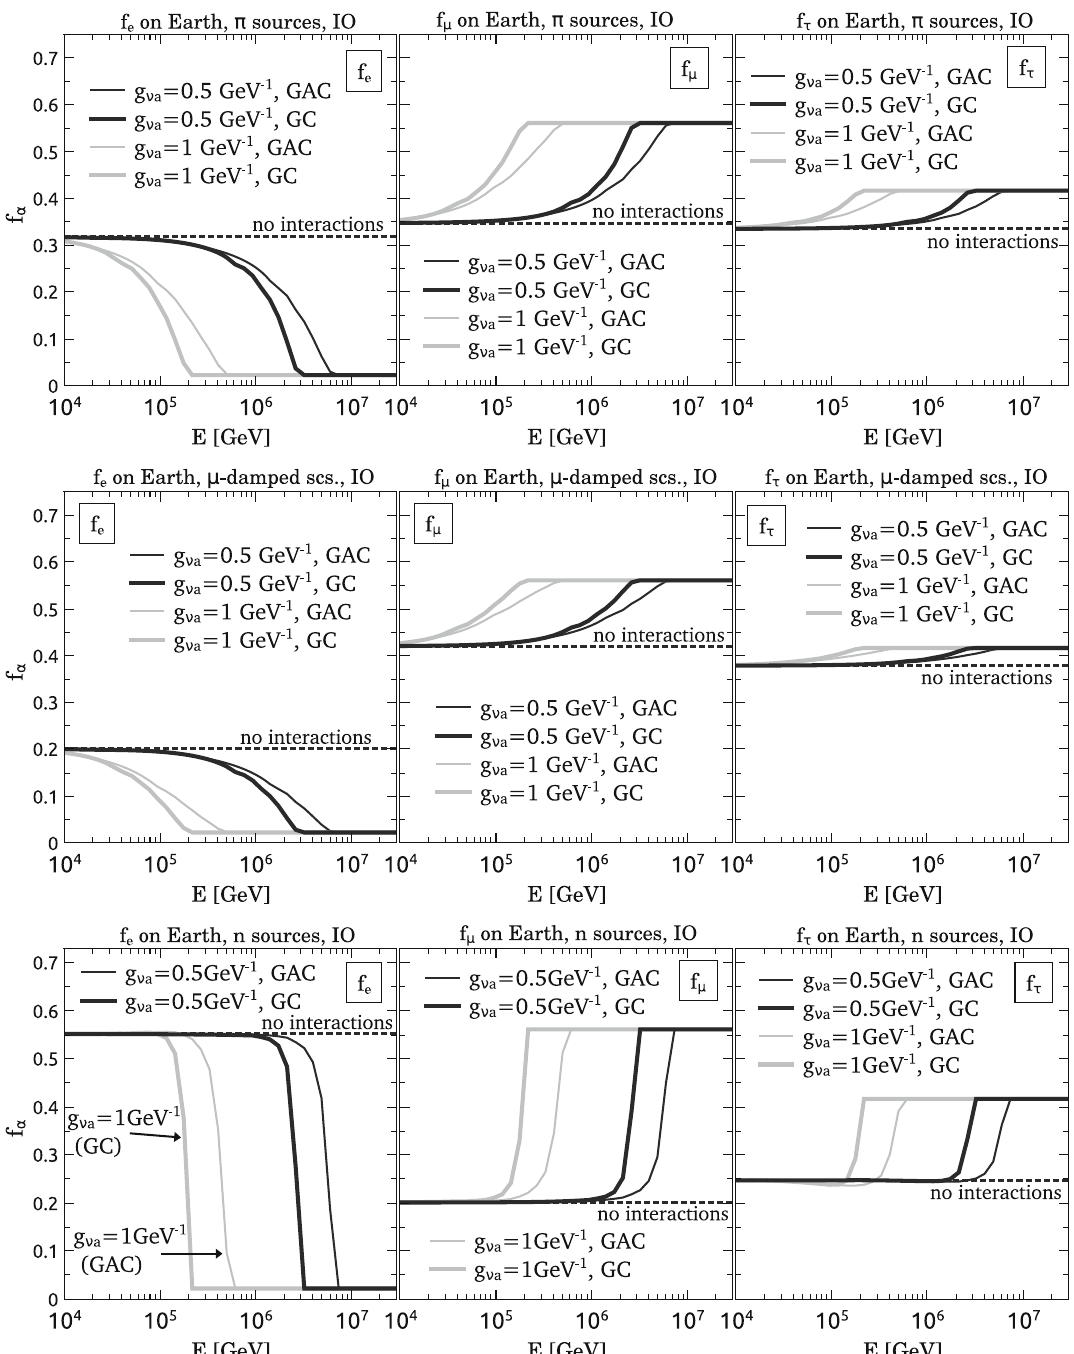
respond to the other half of the sky containing the galactic anti-center (GAC). The results for no interactions are marked using dashed lines. Top panels correspond to pion decay sources, middle panels to muon damped sources, and bottom panels to neutron decay